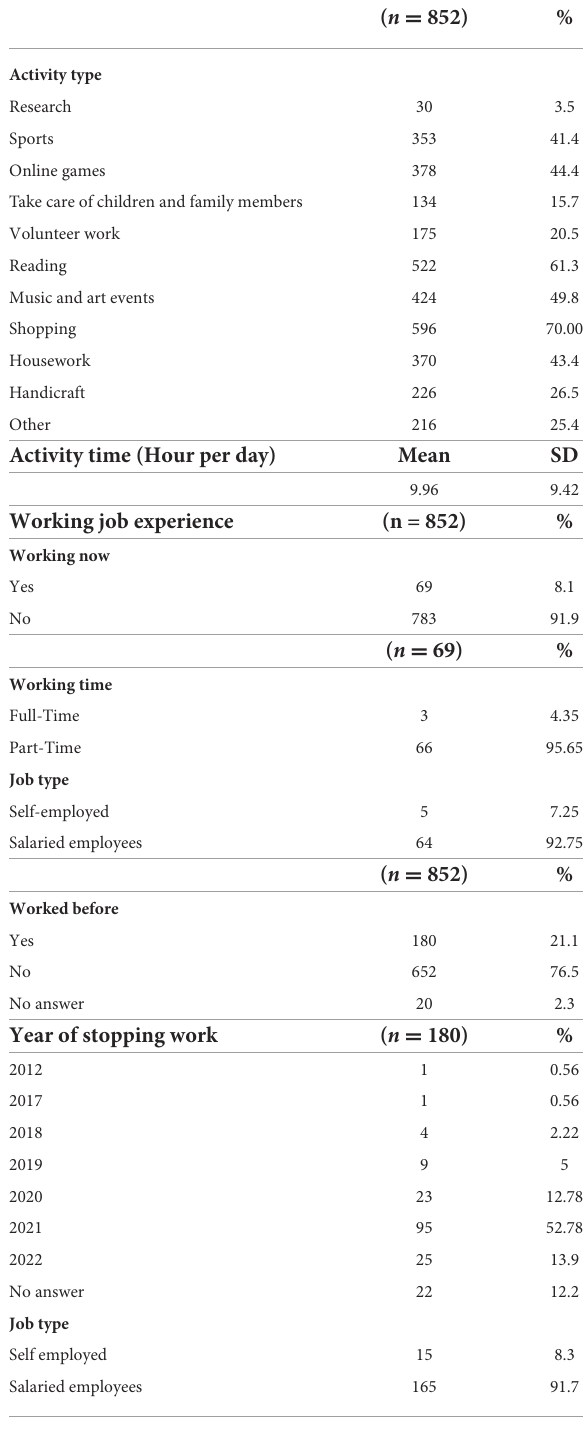
TABLE 3 Demographic characteristics of